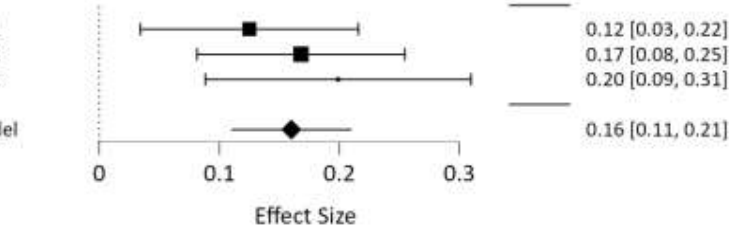
Figure 15. Forest plot of meta-analysis of Motivation for achievement and